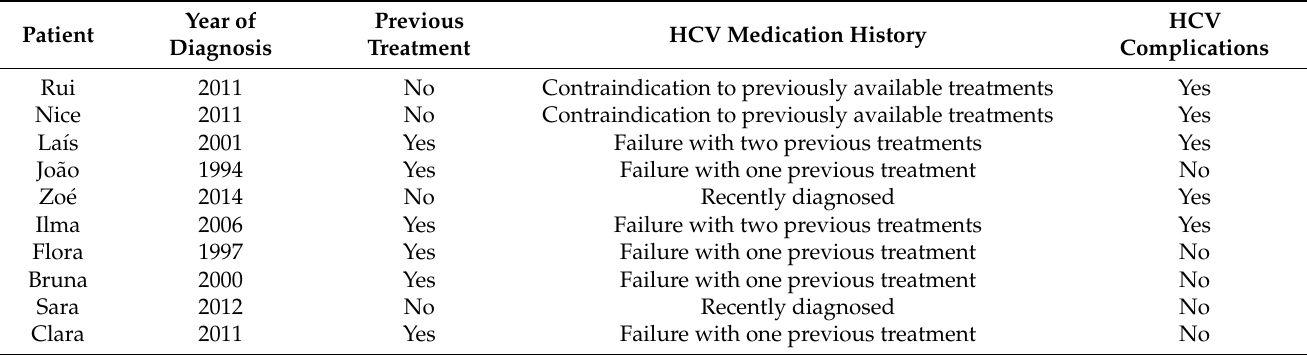
Table 1. Participant’s clinic